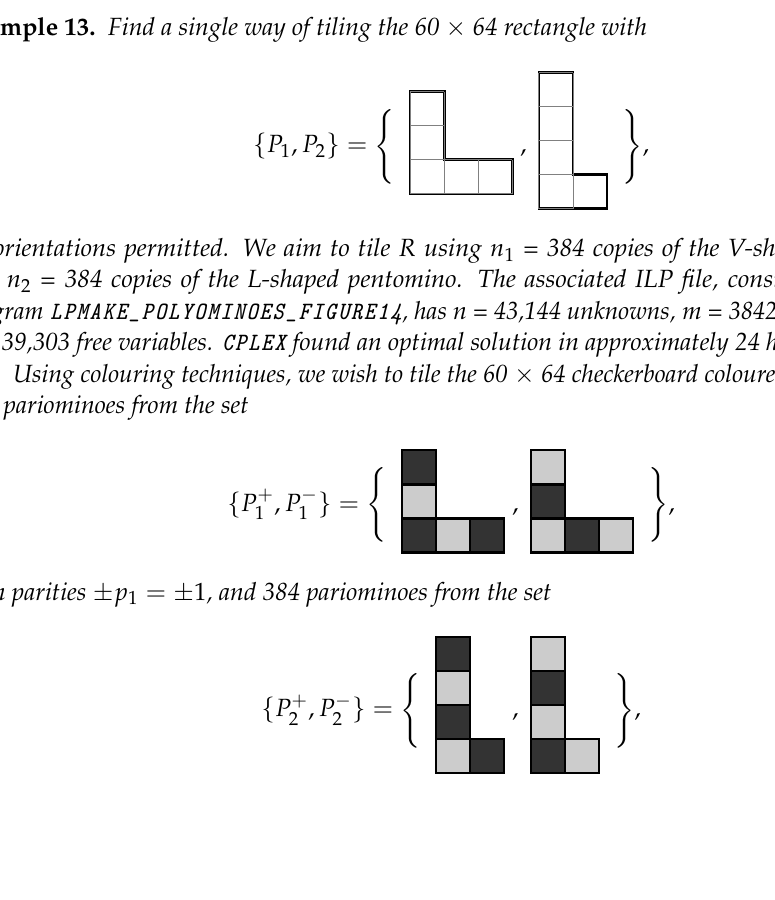
(= P − ), seven copies of P + 2 1 1 and P − . The pariominoes P + , P + , P + , P + , 2 3 4 4 1 4